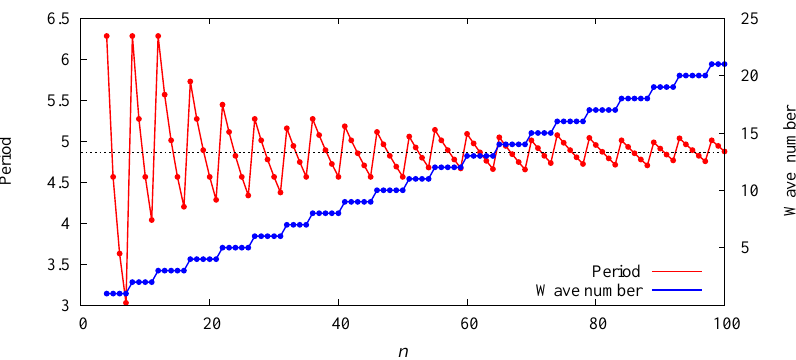
Figure 4. As the equilibrium x F = (F,...,F) loses stability through a (double-)Hopf bifurcation for F > 0 a periodic attractor is born which represents a traveling wave. The spatial wave number increases linearly with n , whereas the period tends to a finite limit.